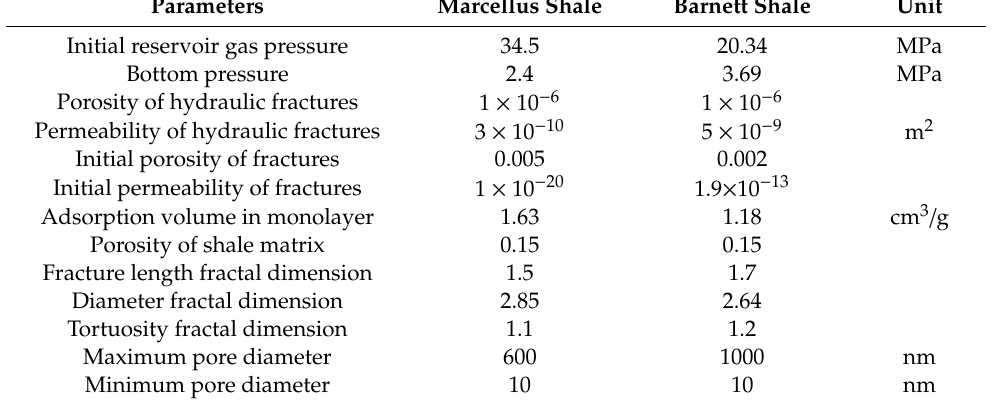
Table 3. Reservoir parameters for the Marcellus shale and Barnett shale wells.